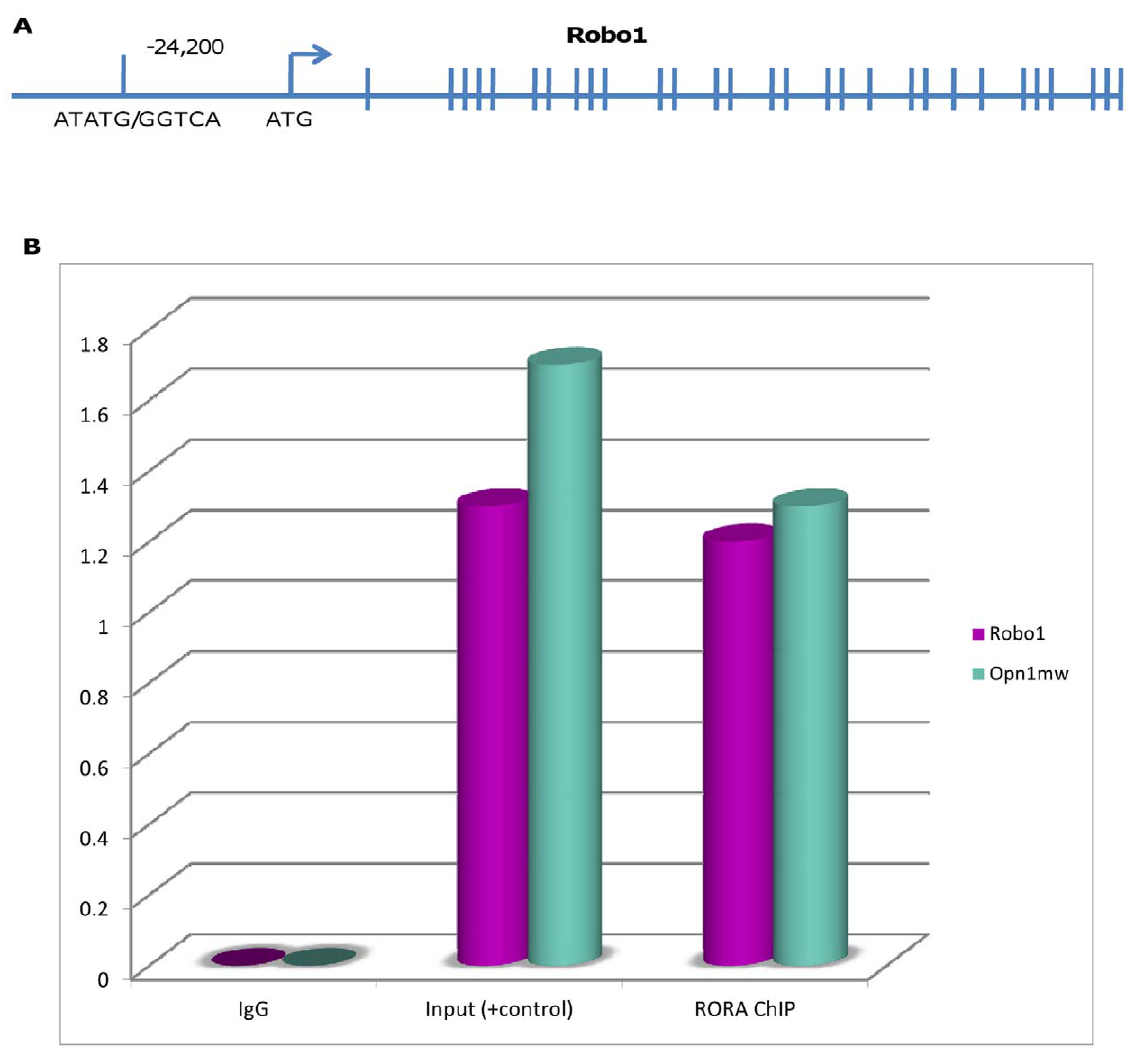
Figure 2. RORA binding upstream to regulatory region of ROBO1 . A. Schematic of ROBO1 gene and approximate location of RORA RE binding site. B. qRT-PCR of ChIP samples using normal, adult, mouse retina identifies Robo1 as a target of Rora. Opn1mw was previously reported as a target of RORA and is therefore a positive control. Neither Robo1 nor Opn1mw amplified out of the IgG ChIP (negative control).